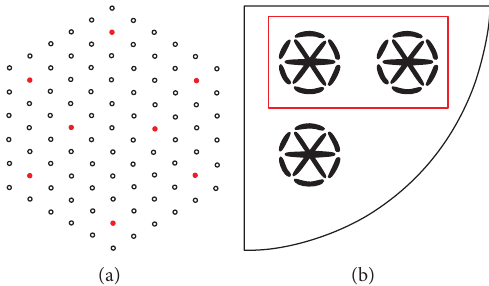
Figure 4: Schematic position of the investigated (a) tips in an array (8 of 91) and (b) chips on each quarter (2 of 3)